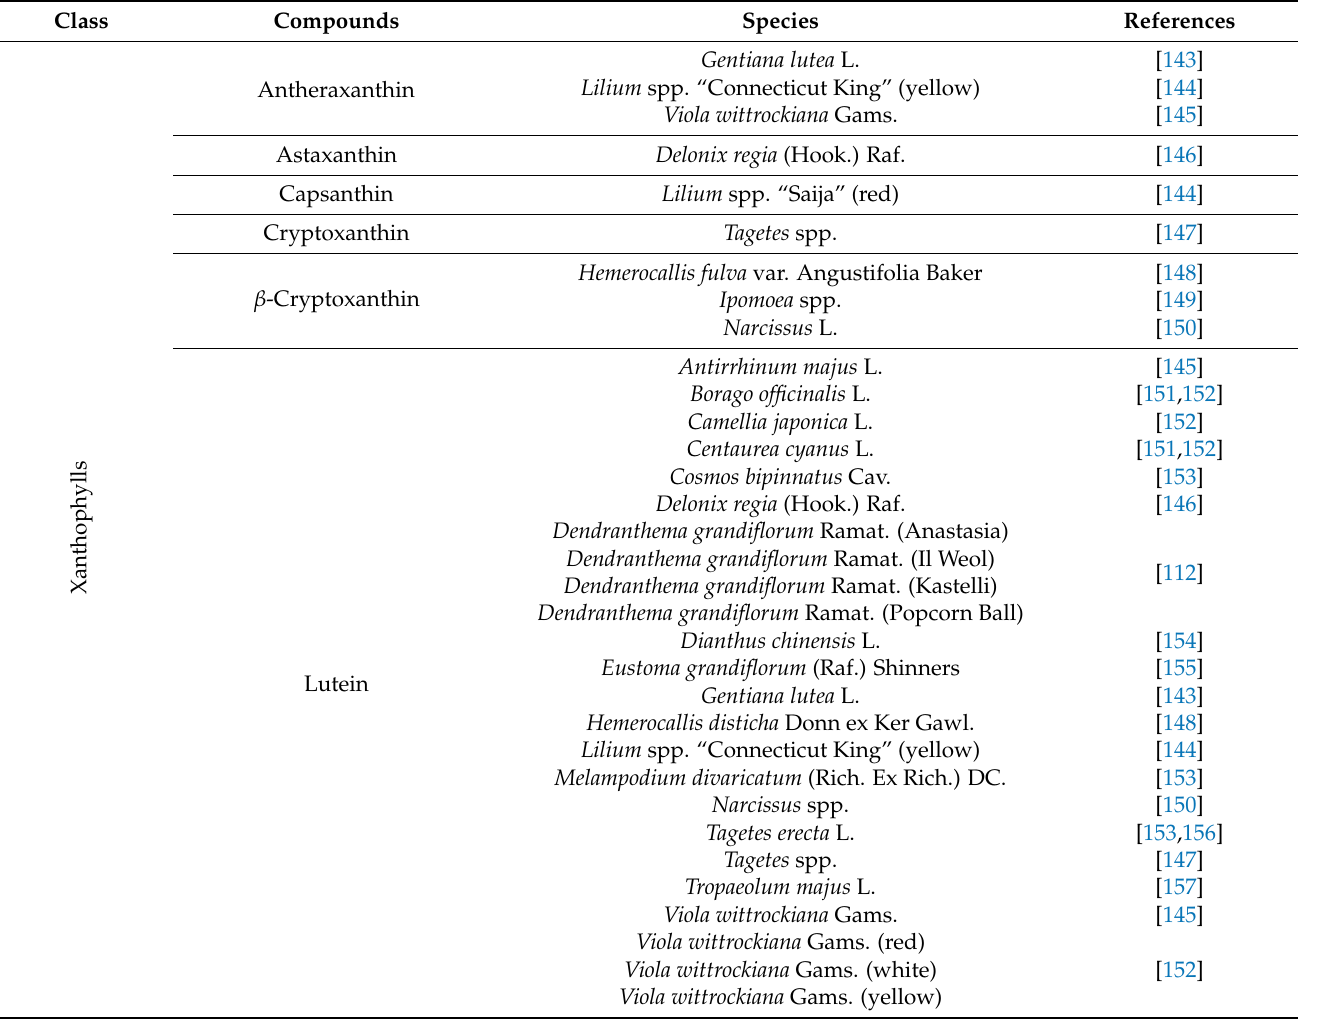
Table 3. The main carotenoids commonly found in edible flowers.